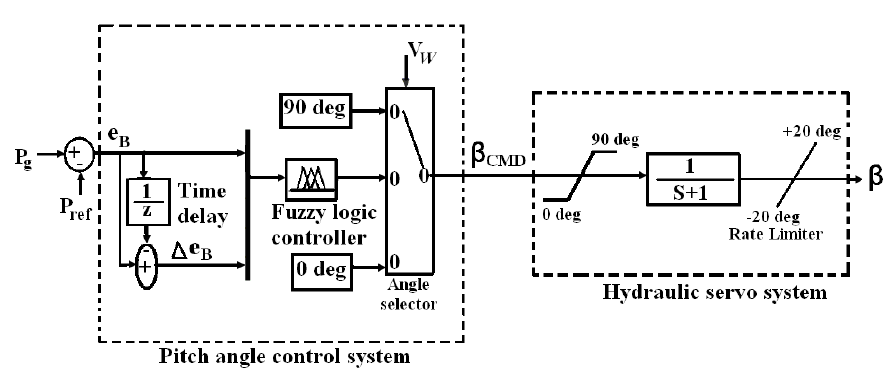
Figure 5. Pitch angle control system structure.